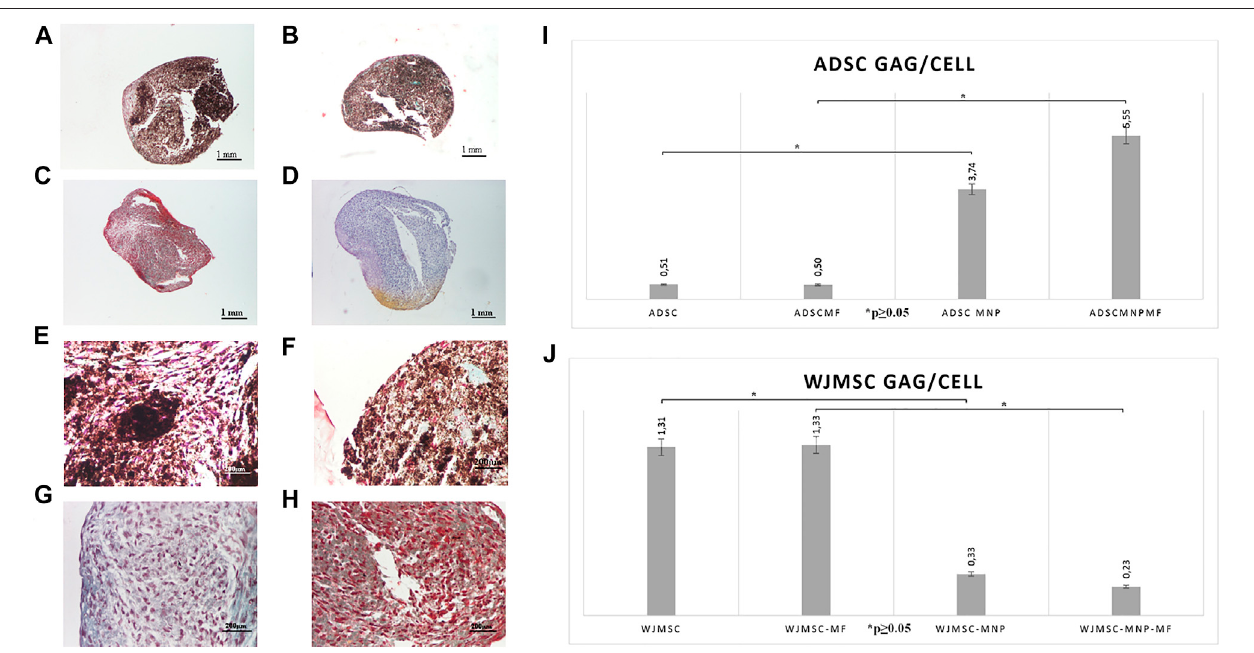
FIGURE 5 | Chondrogensis assay: qualitative: representative histological images of Safranin O stained pellets formed by ADSC-MNP-MF (A) ; ADSC-MNP (B) ; ADSC-MF (C) ; ADSC (D) A-D Nikon Eclipse E600 inverted microscope × 4 magni fi cation; ADSC-MNP-MF (E) ; ADSC-MNP (F) ; ADSC-MF (G) ; ADSC (H) (E – G) Nikon Eclipse E600 inverted microscope × 20 magni fi cation; quantitative evaluation of glycosaminoglycan (GAG) deposition/cell/pellet in ADSC demonstrating signi fi cant increase in GAG deposition in MNP loaded cells as well as in MNP loaded cells submitted to magnetomechanical stimulation within MF compared to non loaded cells (I) ;WJMSCquantitativeevaluationofGAGdeposition/cell/pelletdemonstratingsigni fi cantincreasedGAGdepositioninnonloadedWJMSC;tonote,themaximum amount of GAG deposition is displayed by ADSC-MNP-MF in similar experimental conditions (J)